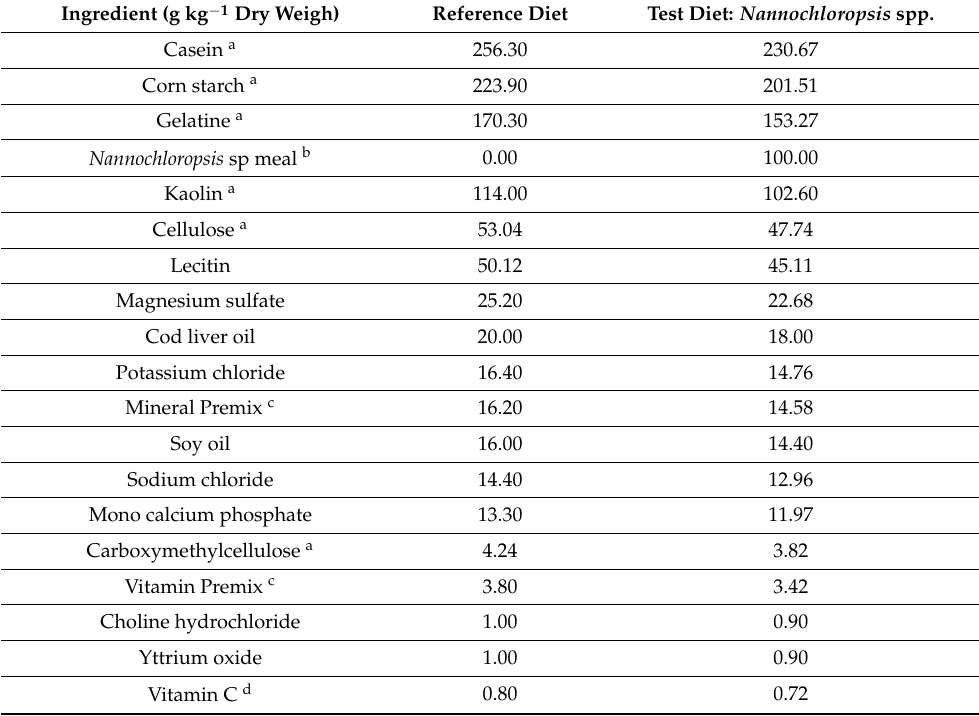
Table 2. Diet formulation for the digestibility